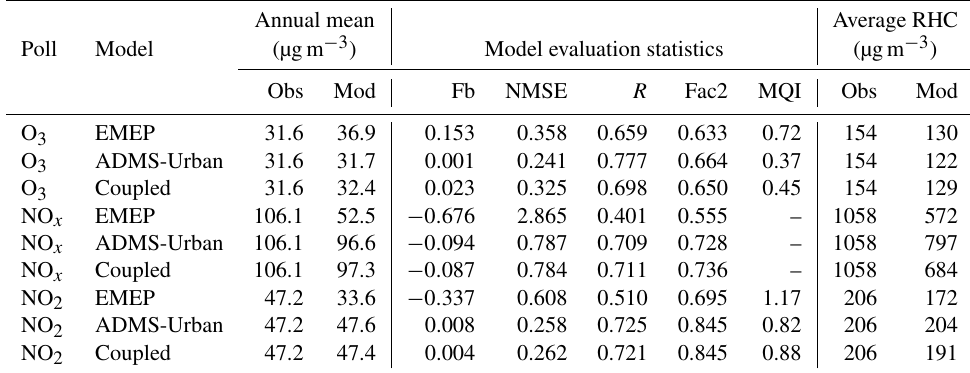
Table 5. O 3 model evaluation statistics calculated at 20 sites, with statistics for NO x and NO 2 at the same sites, for regional (EMEP), local (ADMS-Urban) and coupled modelled hourly concentrations. Statistics as defined for Table 4. Note that MQI is not defined for NO x